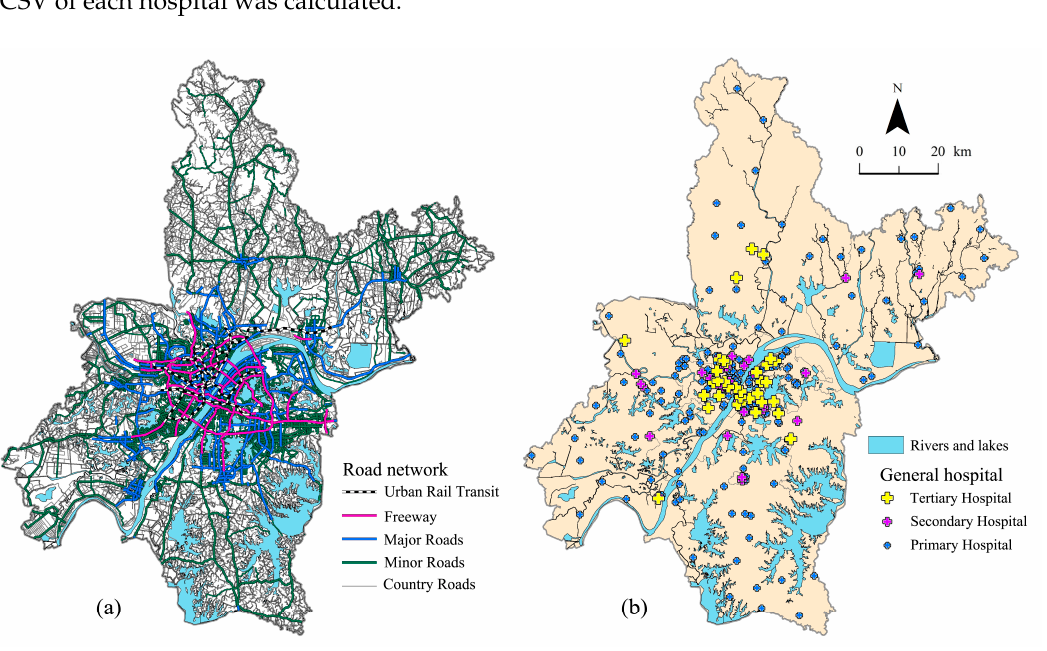
Figure 2. Road network ( a ) and location of selected general hospitals ( b ) in Wuhan city.